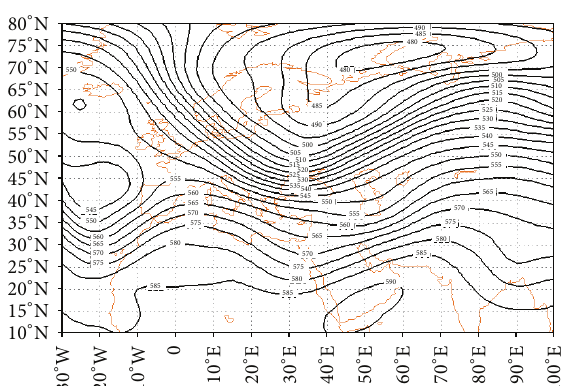
Figure 14: 500 HPa geopotential height level